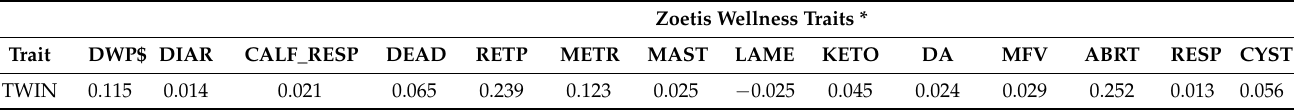
Table 5. Product-moment (Pearson) correlations between TWIN and Zoetis’ Holstein DWP$ index and wellness traits ( n =